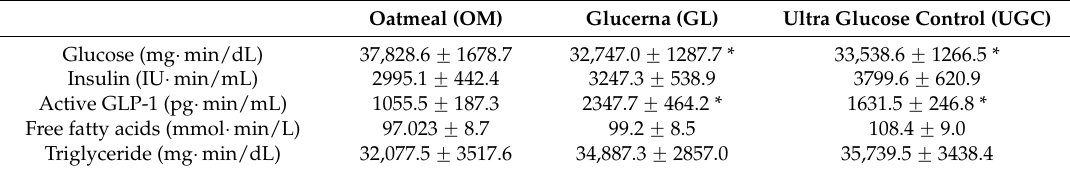
Table 4. Area under the curve 0–240 min for the different variables in response to the meals.